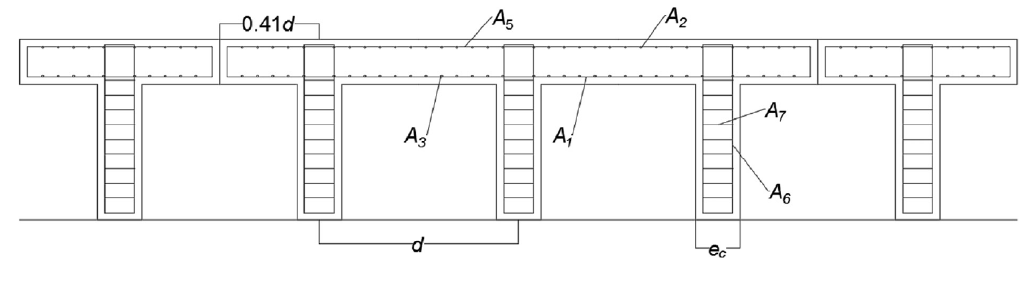
Figure 3. Earth-retaining buttressed wall. Floor cross-section. Source: